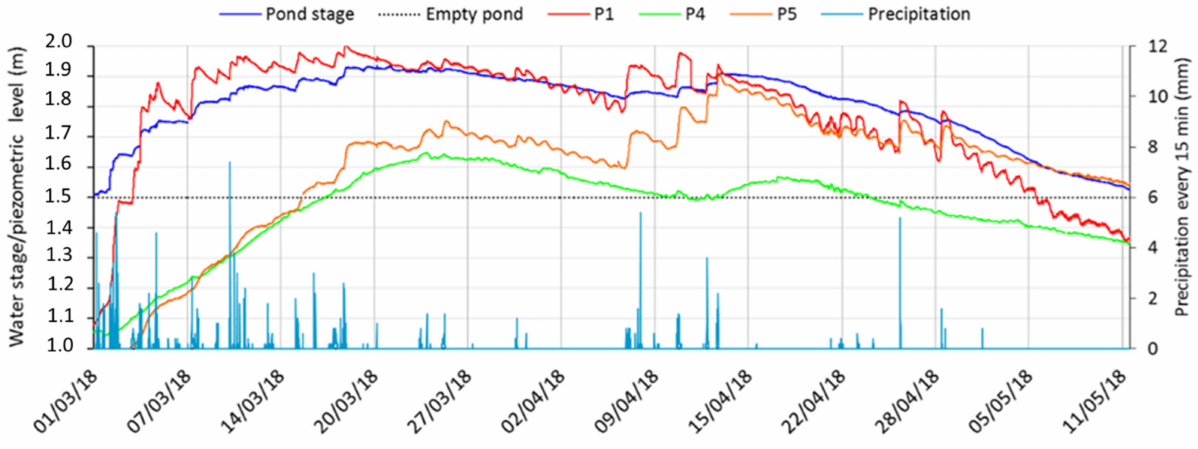
Figure 9. Evolution of the water stage in La Vega pond and in three piezometers of the monitoring network. The distribution of precipitation recorded every 15 min at the APEMSA weather station is